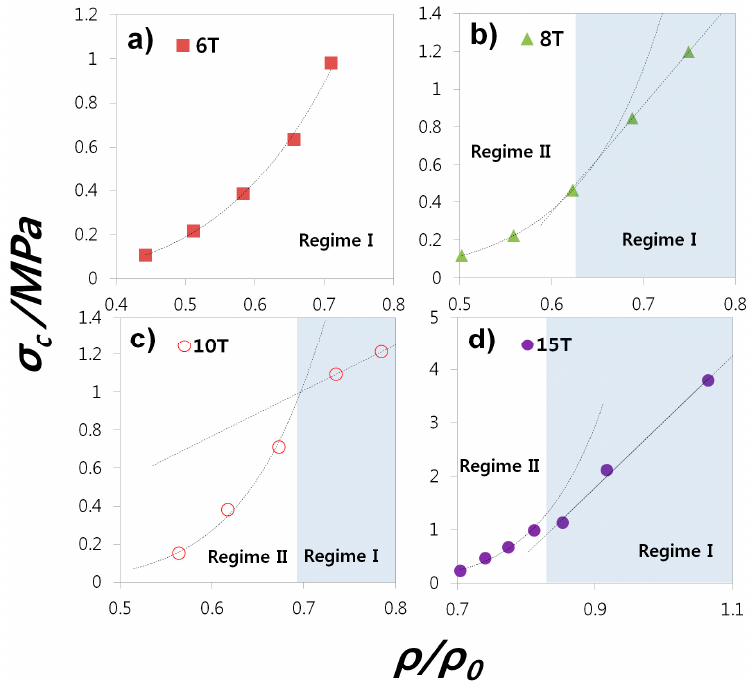
Figure 3. Various compressive strength ( σ C ) plot as a function of volume ratio ( ρ / ρ 0 ) at different pad (bulk) thickness ( t pad = ( a ) 6 T, ( b ) 8 T, ( c ) 10 T and ( d ) 15 T). Materials 2018 , 11 , x FOR PEER REVIEW